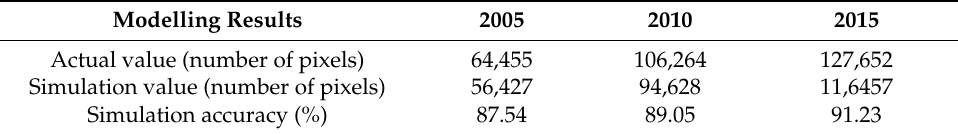
Table 3. The SLEUTH model simulation accuracy.